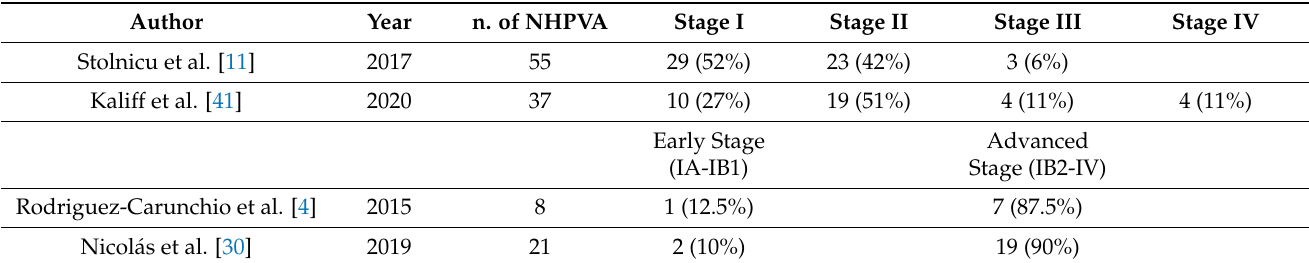
Table 5. Frequency of disease stages in non-human papillomavirus-associated adenocarcinoma cohorts.